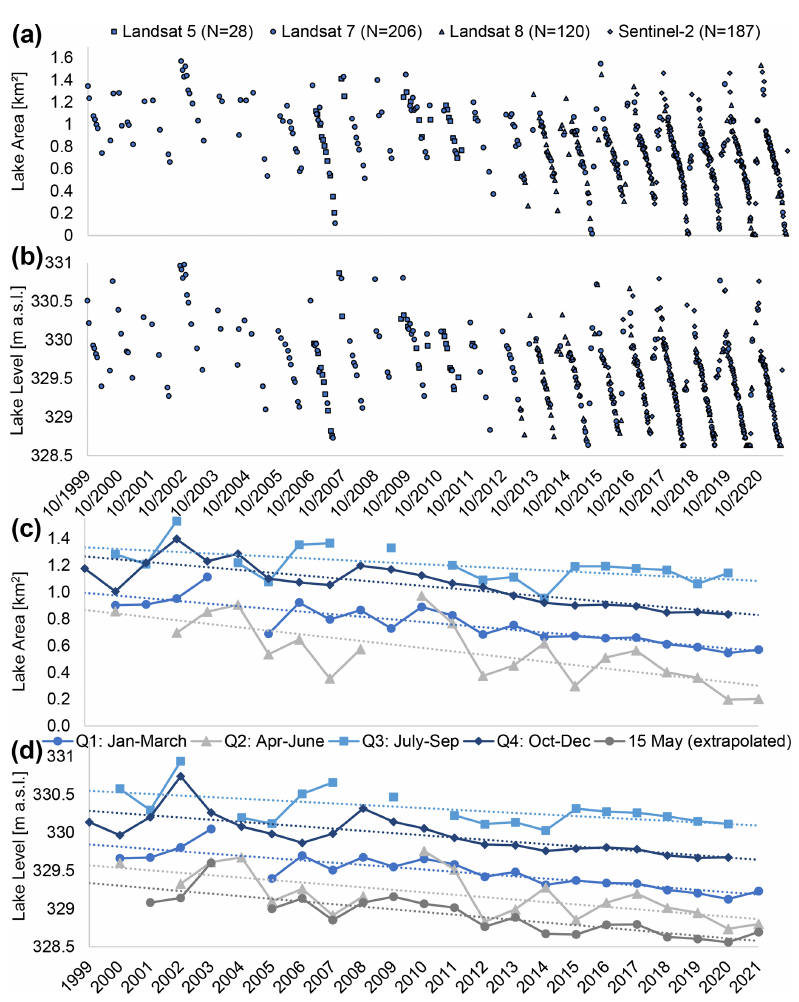
Figure 4. Time series of (a) lake area and (b) lake water level retrieved from Landsat 5, 7, and 8 as well as Sentinel-2 optical satellite imagery for the period 1 October 1999 until 30 June 2021. N is the number of scenes available from each sensor. In total 541 scenes are represented. (c) Annual average quarterly lake areas and (b) lake levels with associated linear trend lines. Lake levels from 15 May in (d) represent the level at the approximate end of the dry season and are identified based on extrapolated lake levels (Fig.